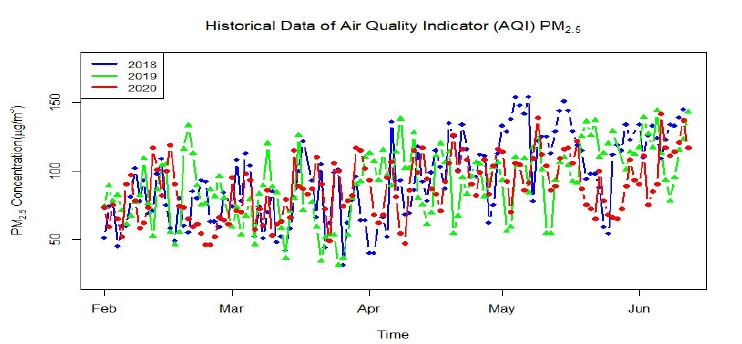
Fig. 1 . Time series plots of PM 2.5 concentrations in the periods without and during the period with